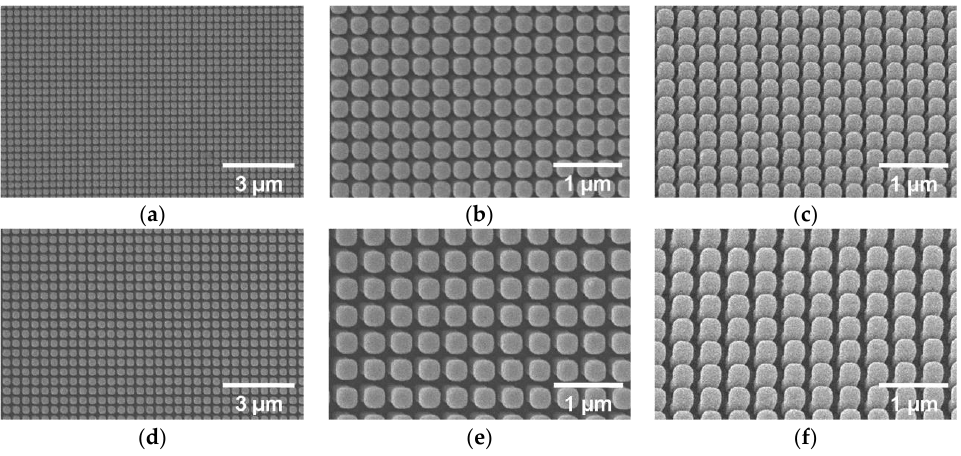
Figure 3. SEM images of the Au nanopost-shell arrays fabricated by NIL: ( a – c ) P300, and ( d – f ) P400 samples.